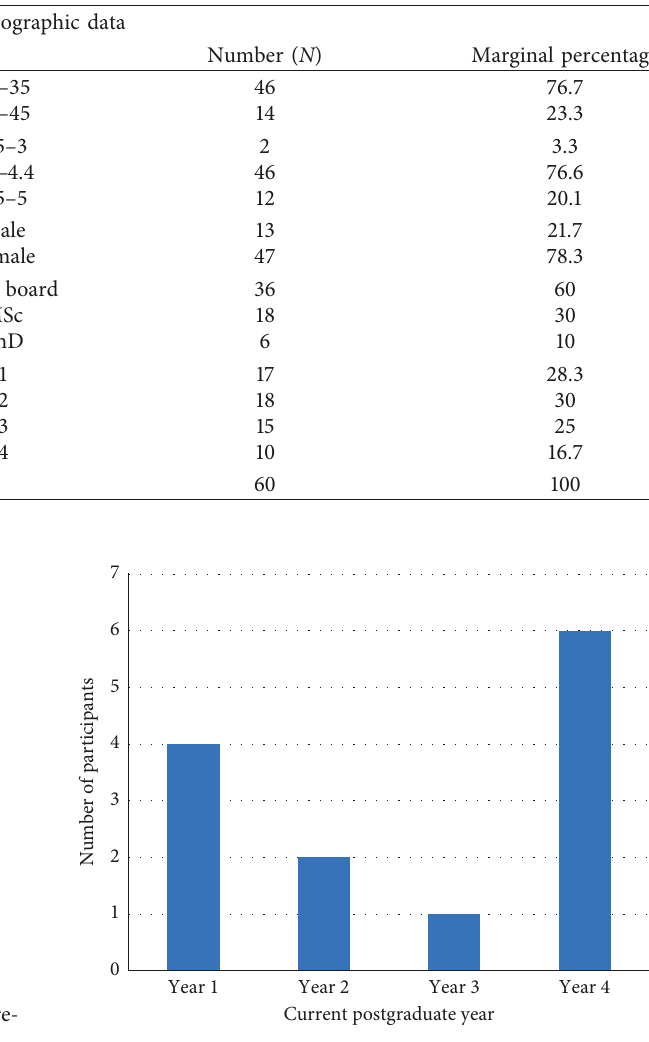
Table 1: The sociodemographic information of the participants.